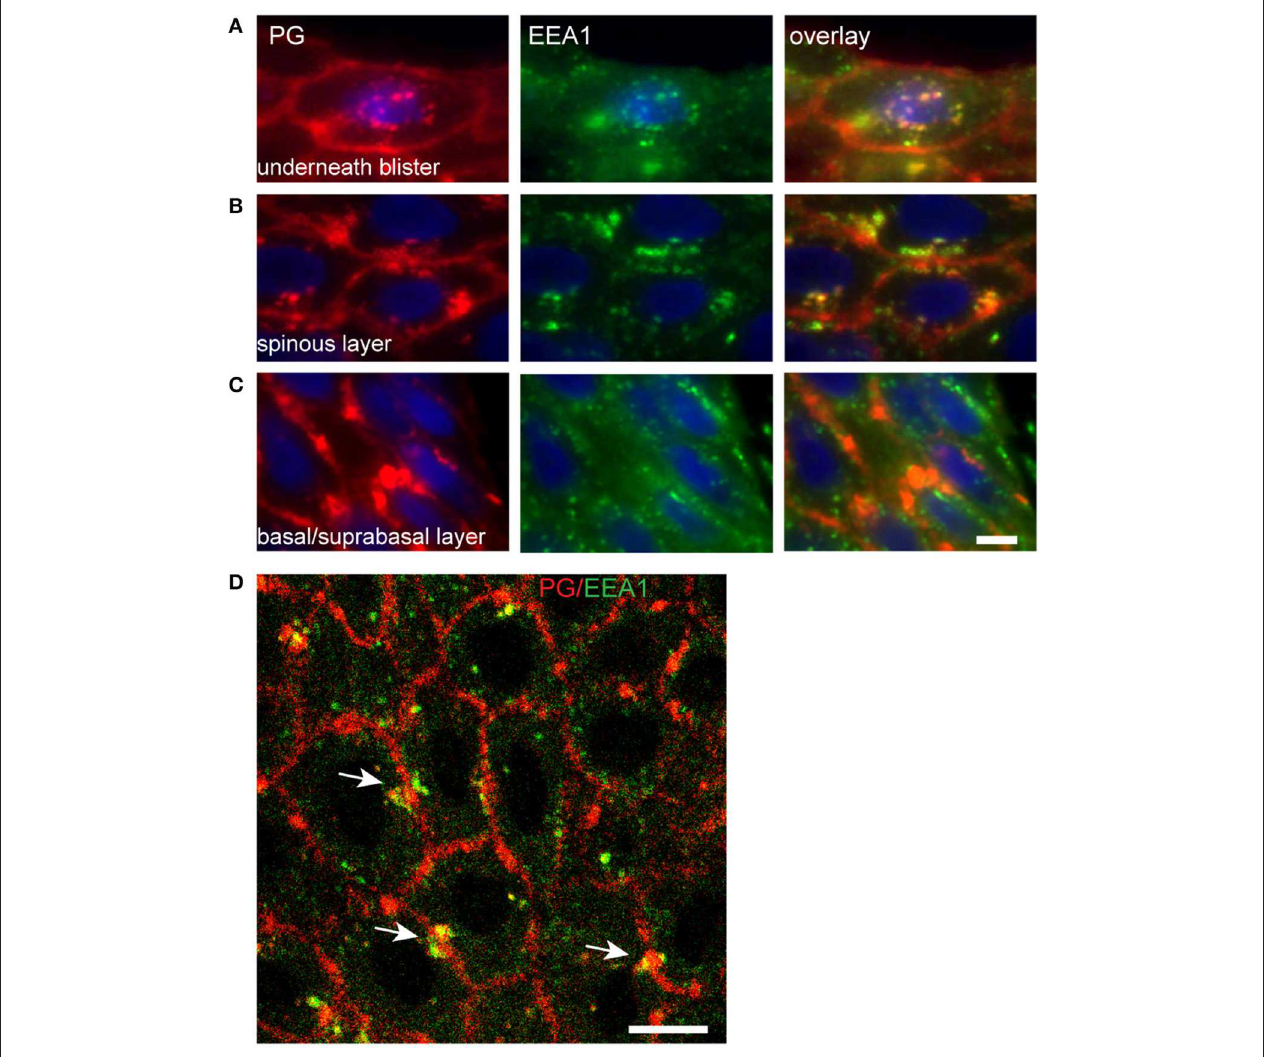
FIGURE 9 | Endocytosis of plakoglobin starts in the spinous layer. Lesional PF skin stained for PG (red) and EEA1 (green). (A) Below the blister cavity; (B) spinous layer; (C) basal/suprabasal layer. Note the colocalization of PG and EEA1 in the spinous layer and below the blister cavity. White bar: 5 µ m. (D) Confocal microscopy of lesional PF skin stained for PG (red) and EEA1 (green). White arrows indicate symmetrical endocytosis into neighboring keratinocytes. White bar: 10 µ